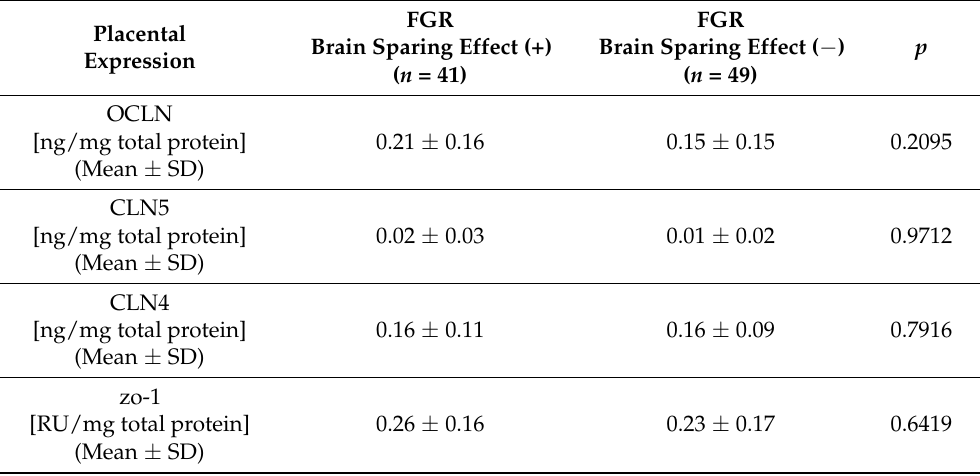
Table 4. Placental expression of the tight junction proteins in a FGR pregnancy in the presence or absence of the brain sparing